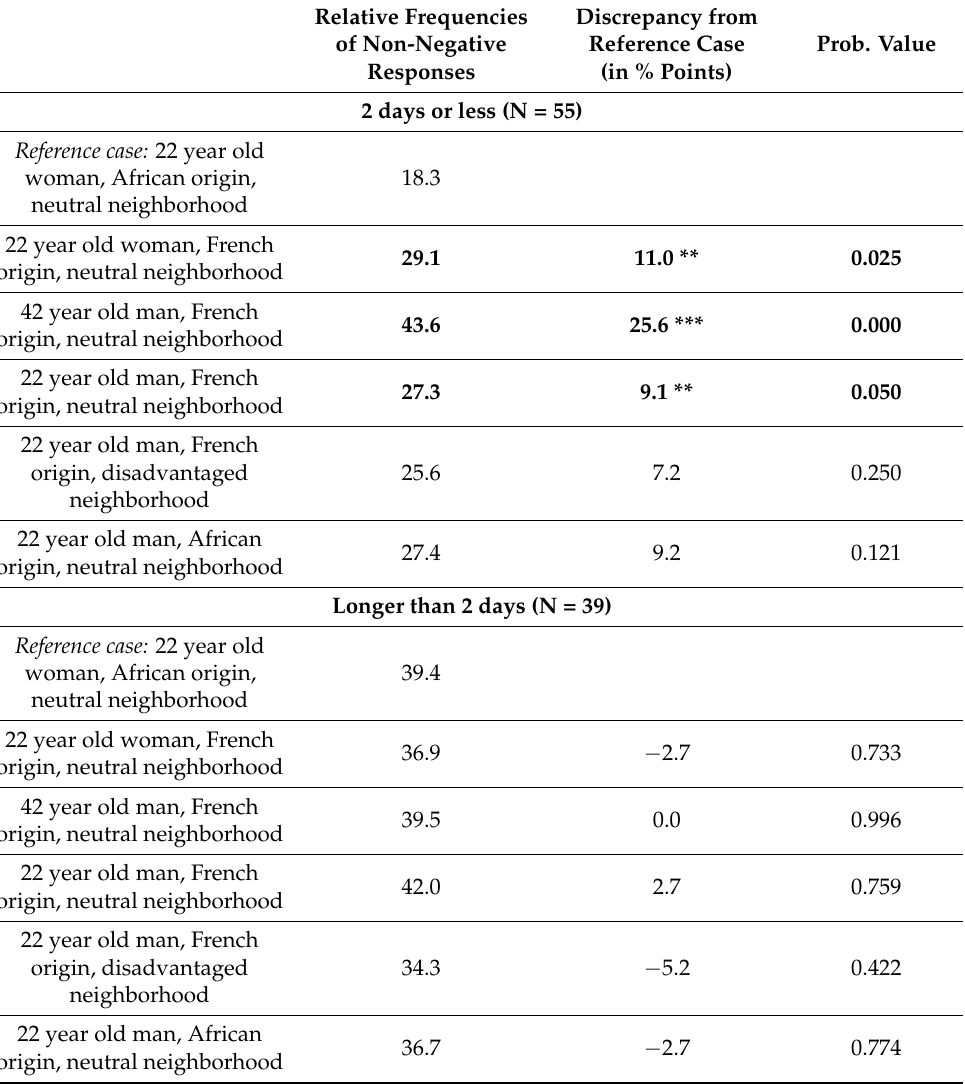
Table A1. Differences in the non-negative response rate emanating from the same vocational training organizations (estimated discrimination parameters) cross-tabulated by duration of training.